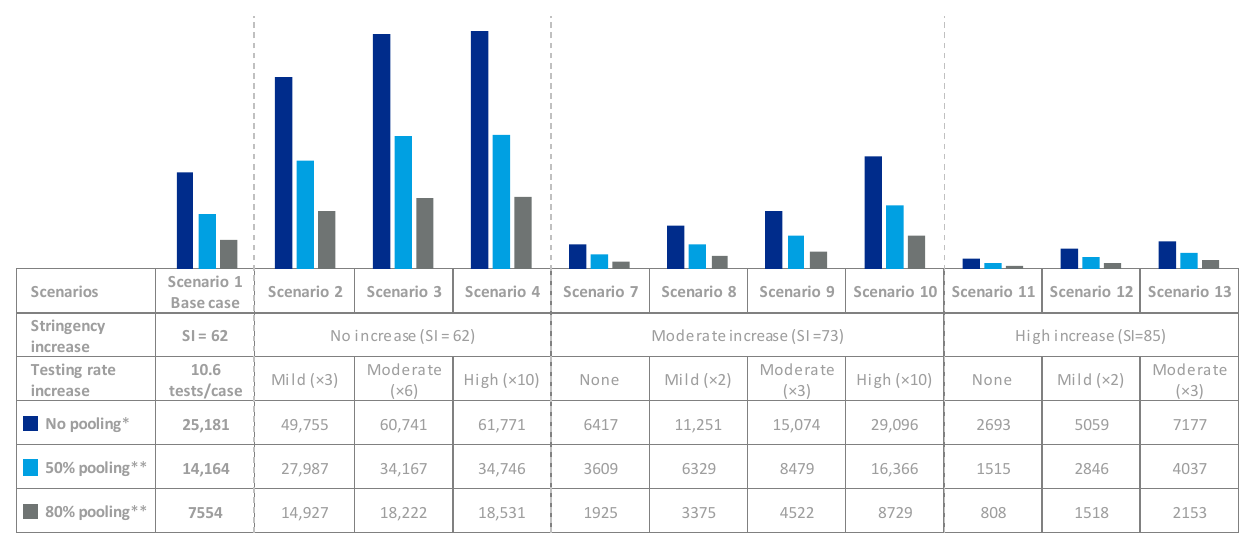
Figure 5. Pooling Efficiency . * Thousand tests and thousand individuals tested. ** Thousand tests.